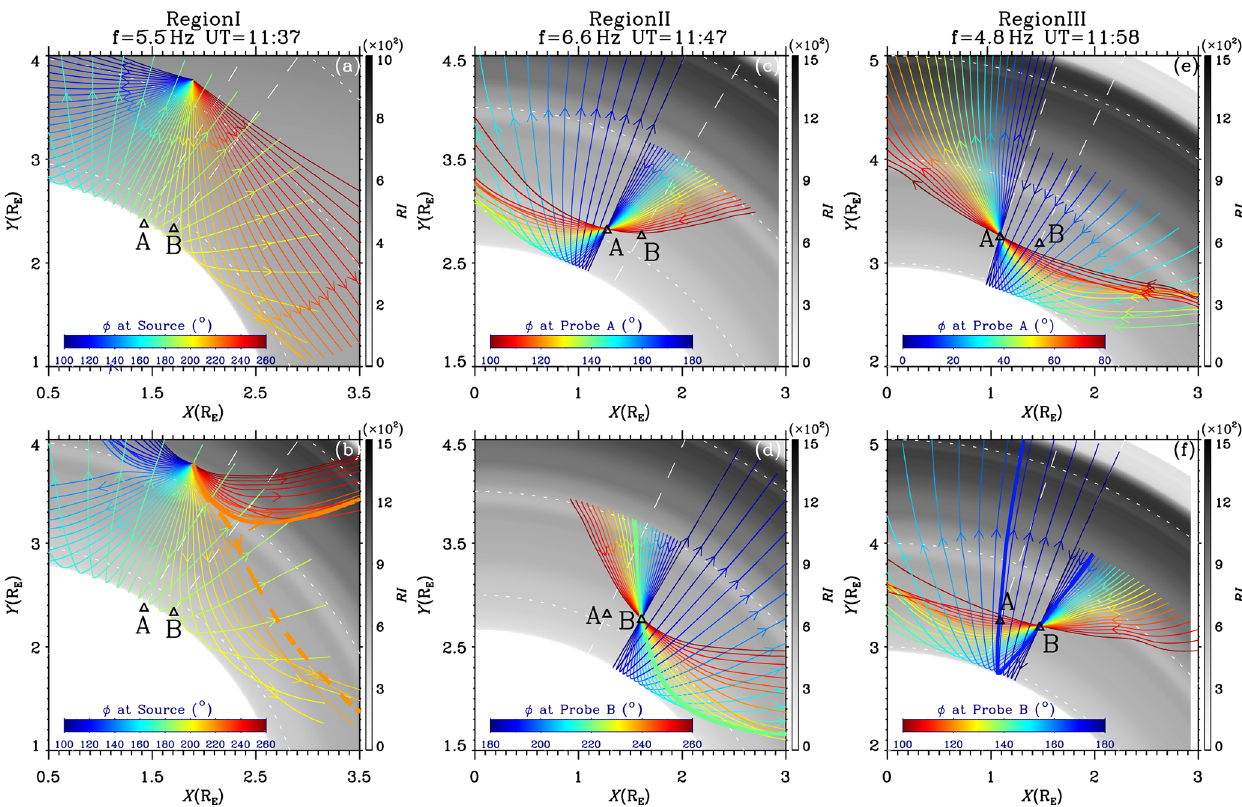
Figure 4. Ray-tracing simulations in the X – Y (equatorial) plane of the SM coordinates. The left, middle and right columns show the simulations at three different points in time–frequency domain. The first two rows show the paths of the rays that (a, b) launched at a fixed source, (c, e) pass through probe A and (d, f) pass through probe B. The rainbow color bars in each panel represent the azimuthal angles of the rays at the corresponding intersection point of rays. The black–white color bars represent the refractive indexes of the background plasmas. The arrows denote the directions of the rays. Model magnetic field and density are used in (a) , while the observed magnetic field and density are used in (b–f) . The positions of the two probes are marked by triangles. In the second row, the thicker lines denote the selected rays which undergo analyses in Fig. 5.